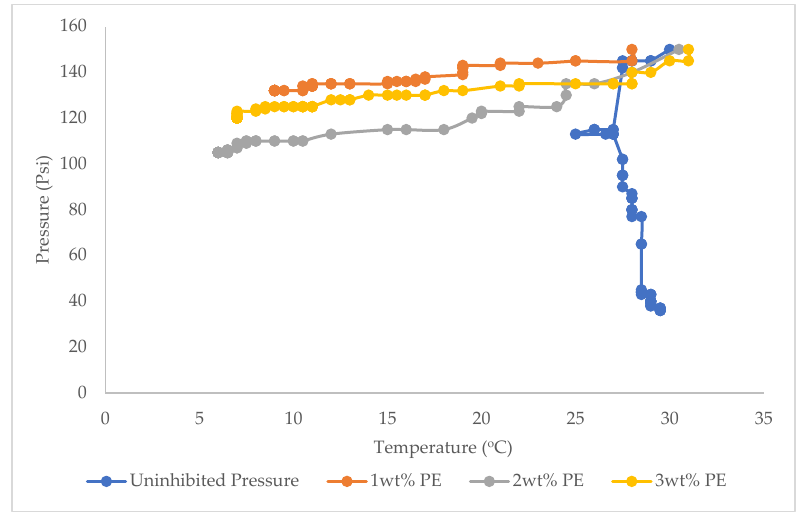
Figure 5. Pressure versus Temperature plot for 1, 2 and 3 wt% PE and Uninhibited Experiment. 3.2. Comparison of the Inhibitory Capacities of Plant Extract (PE) and Mono Ethylene Glycol (MEG)